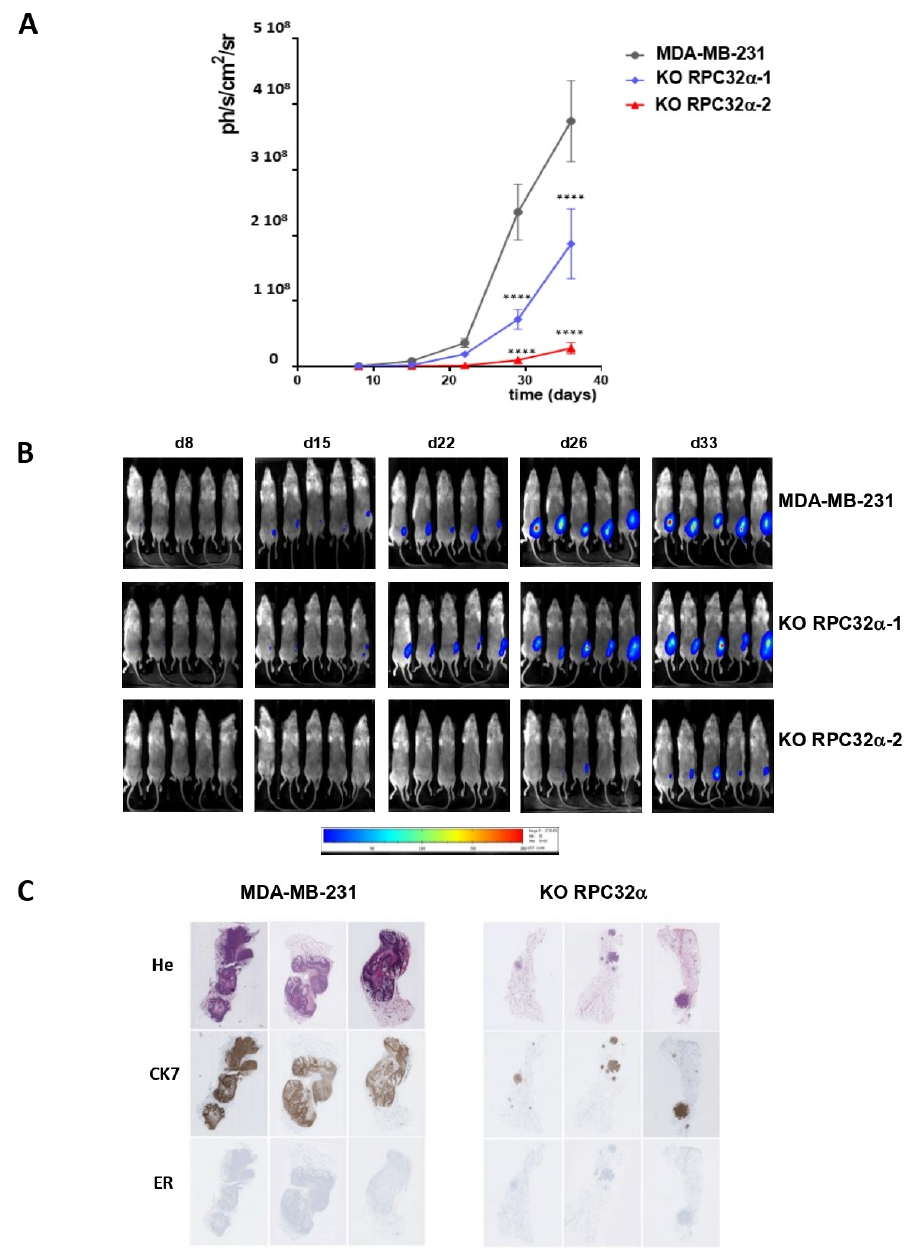
Figure 6. Orthotopic xenografts of MDA-MB-231-derived RPC32 α KO cells show reduced primary tumor growth and metastasis formation. ( A ) Time course for mammary tumor growth of ortho- topically xenografted MDA-MB231 and POLR3G KO (3GKO) cell lines as appropriately indicated. Tumor bioluminescence was measured using a Photoimager and normalized to the starting value one week after injection. Logarithmic representation of mean luminescence of two independent experiments with ten mice each (**** p < 0.0001 compared to MDA-MB-231). ( B ) Representative bioluminescence imaging on live animals at days 8, 15, 22, 26 and 33 (as indicated above the images) post-orthotopic xenograft for each group. Mice that were xenografted with the MDA-MB231 cell line are shown in the uppermost row, and those that were xenografted with the two distinct POLR3G KO (3GKO) cell lines are shown in the lower two rows, as appropriately indicated to the right. ( C ) Overall morphology of formalin and paraffin embedded tumors analyzed by H&E staining (uppermost row). Immuno-histochemical staining of the same samples with anti-human cytokeratin 7 (CK7; middle row) or anti-estrogen receptor antibodies (ER; row to the bottom) as indicated to the